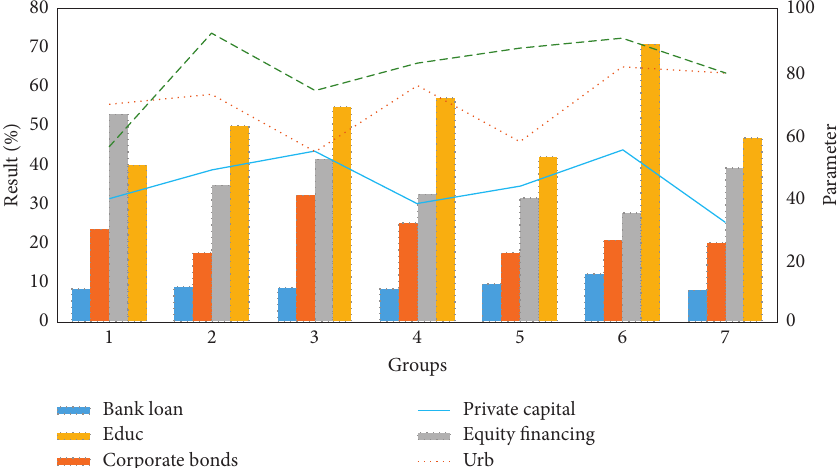
Figure 11: Final value of credit risk